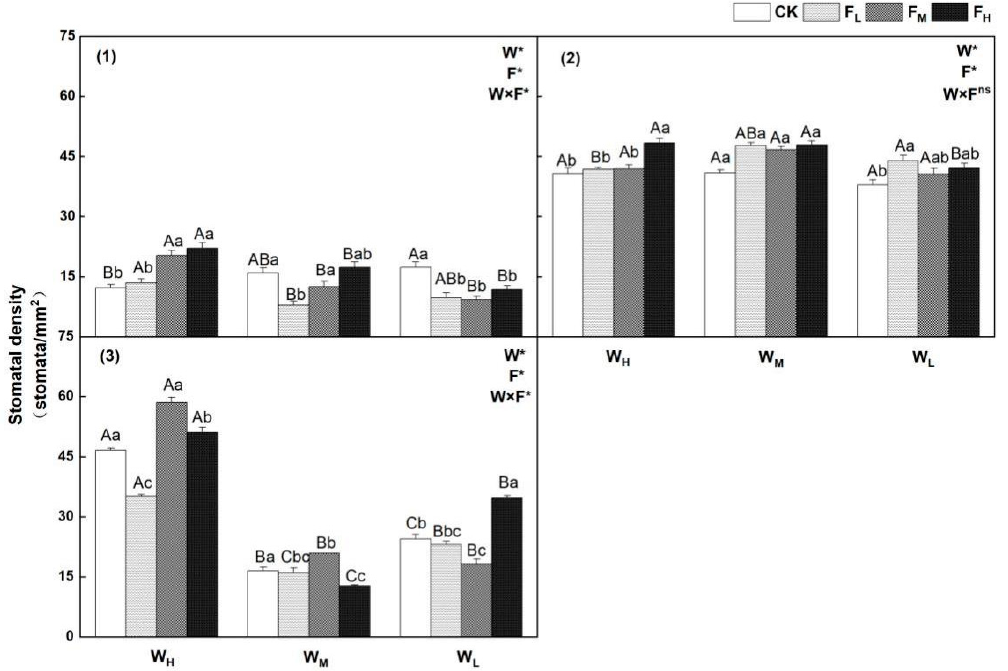
Figure 6. Changes in stomatal frequency values of test plant species under different water–fertilizer treatments. Numbers ( 1 ) − ( 3 ) in brackets indicate P. crymophila , F. coelestis , and S. purpurea , respectively. W, F, and W × F indicate the results of ANOVAs ( p < 0.05) for the effects of water, fertilizer, and their interactions. Asterisk (*) and ns indicate significant difference and non-significant. The uppercase letters and lowercase letters represent the difference between water and fertilizer treat- ments.